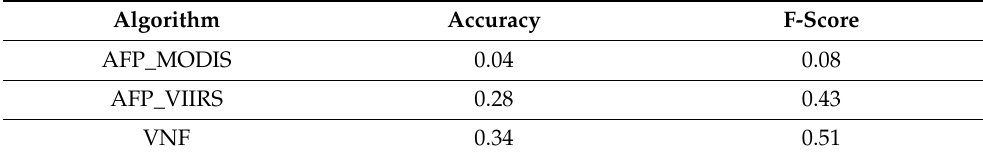
Table 1. Accuracy and F-score for detection algorithms VNF (MWIR only), AFP VIIRS and AFP MODIS.